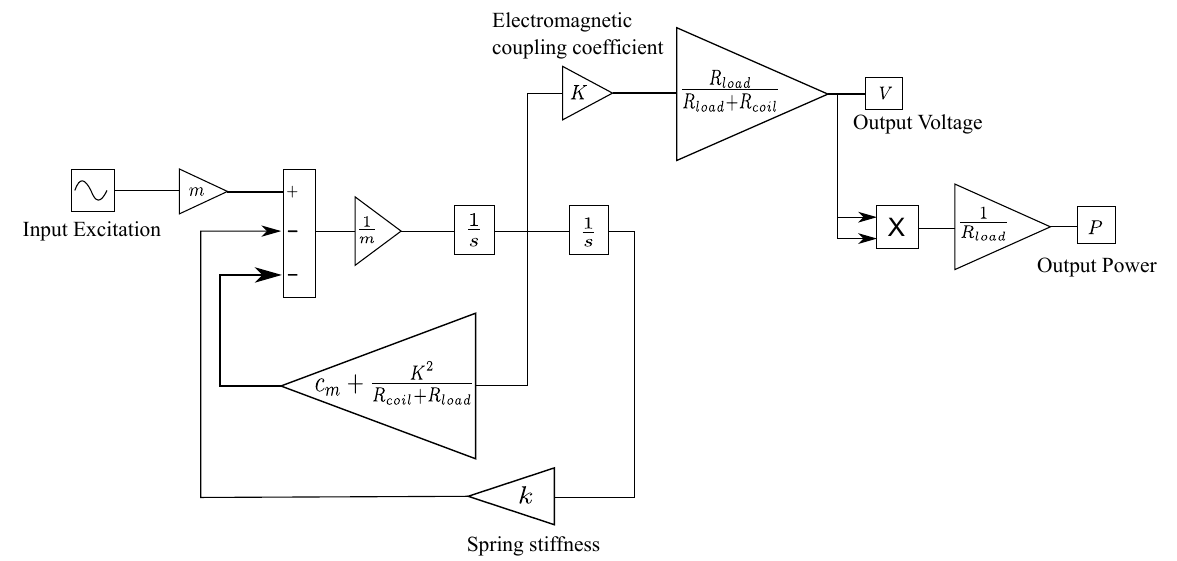
Figure 6. Implementation of the differential equations of the electromagnetic energy harvester for output power